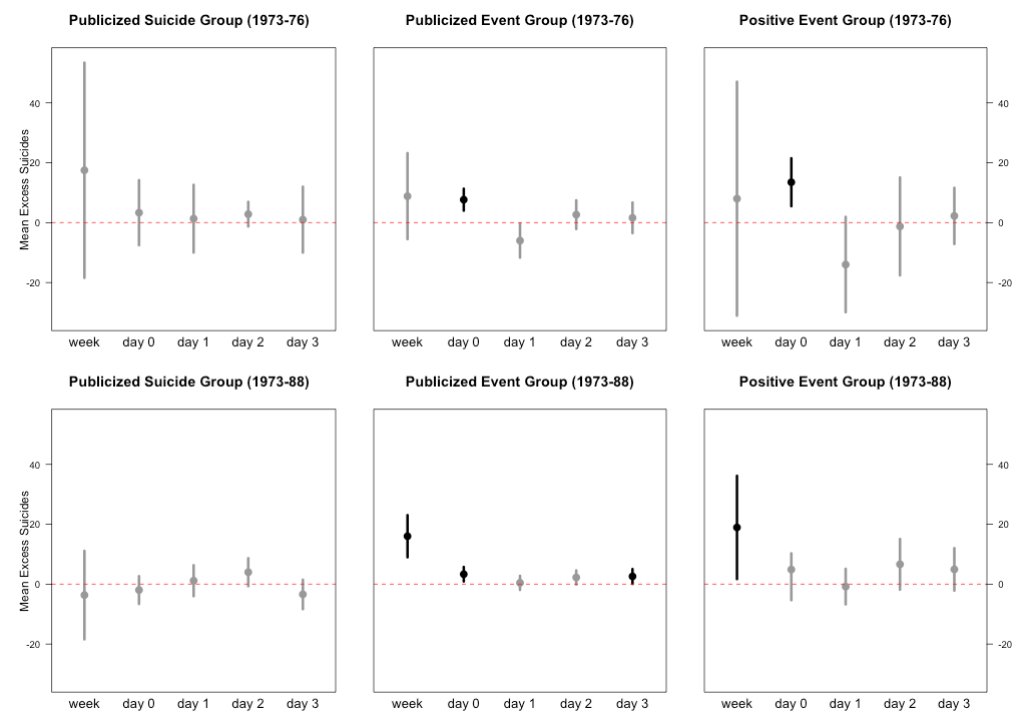
Figure 2: The effects of celebrity suicide and exceptional events in a quasi-experimental